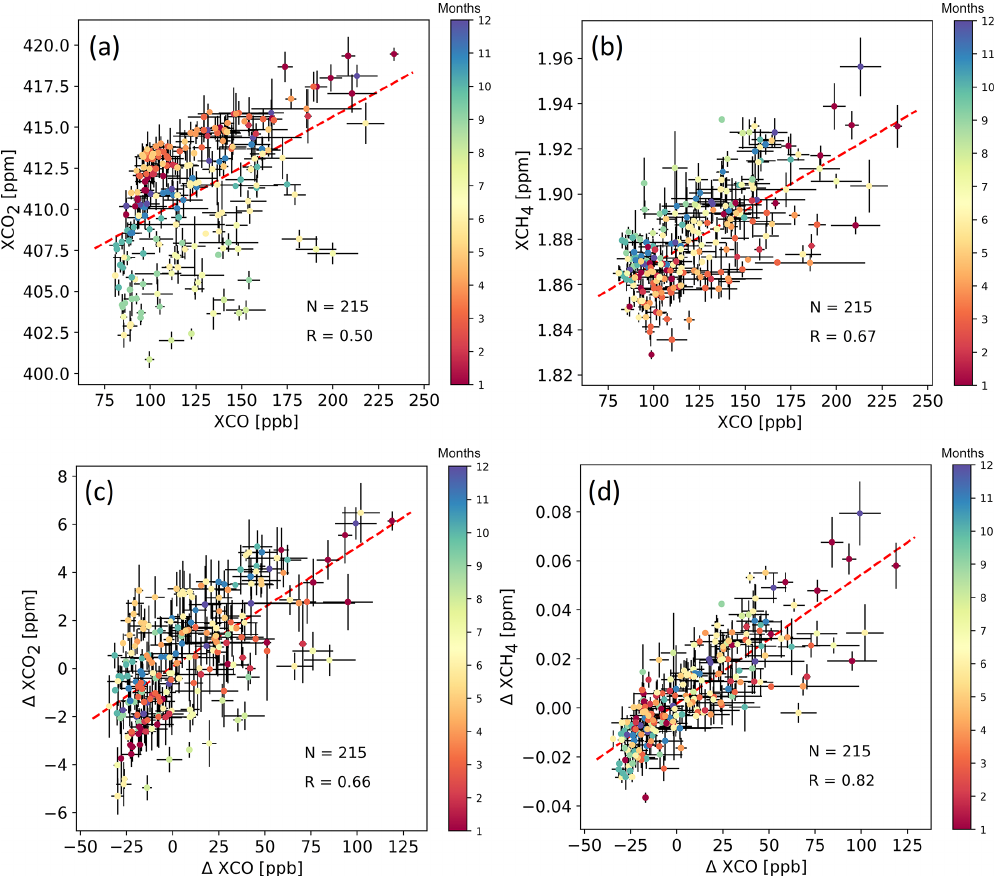
Figure 10. The correlation plots between the XCO and XCO 2 and XCH 4 daily means (a, b) and the correlation plots between the (cid:49) XCO and (cid:49) XCO 2 and (cid:49) XCH 4 daily means (c, d) from FTIR TCCON-type measurements at Xianghe. The dashed red line is the linear fit. N is the number of the measurement days, and R is the correlation coefficient. The error bar is the SD of the measurements on each day. The data are colored with the measurement